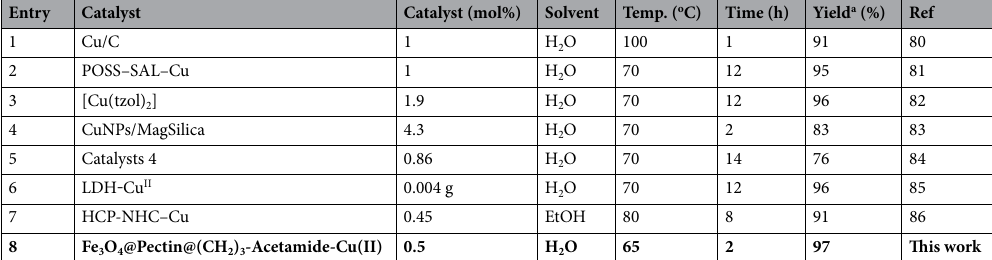
Table 3. Synthesis of 1-benzyl-4-phenyl-1H-1,2,3-triazole (4a) using different catalysts and reaction conditions. a Yields of isolated product. Significant values are in bold.